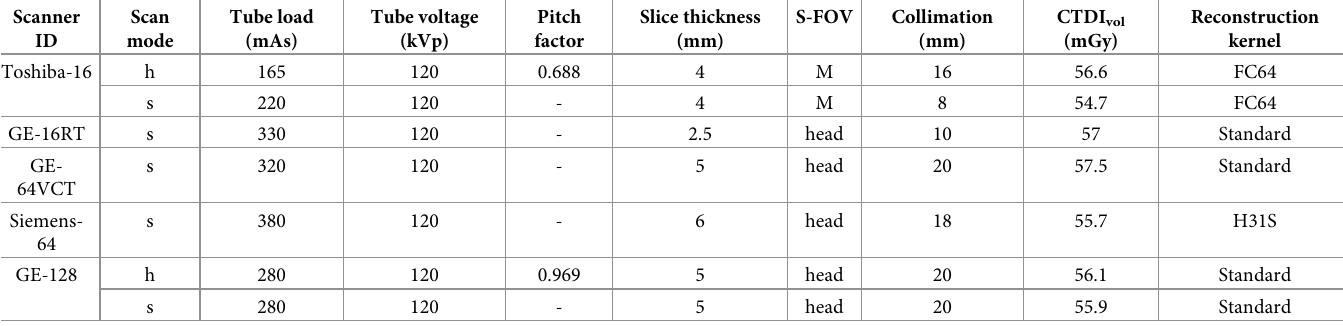
Table 3. Clinical head CT imaging protocols used for each scanner by the staff of various Radiology/Neuroradiology departments at the Pisa university hospital. Scanner